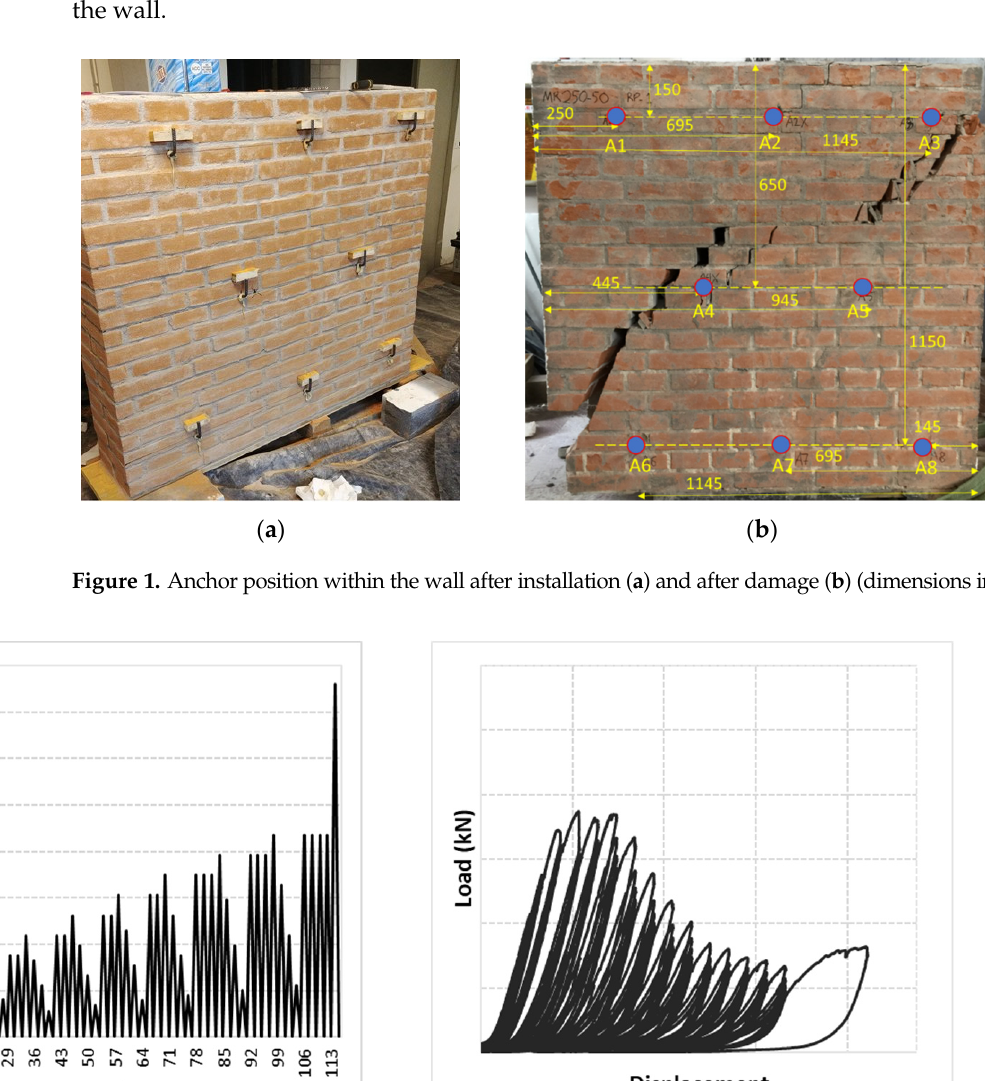
Figure 2. ( a ) Test protocol and ( b ) example of load-displacement curve of the actuator response of a wall ( b ). At the end of the wall tests the reinforced plaster was detached, and the masonry showed several major cracks along the diagonal. For the anchor tests, each anchor had a code (A1, A2 . . . A8) depending on the position within the wall (Figure 1). Figure 3. After the wall testing phase, most of the anchors were bent (Figure 4) which required additional measures to perform a tension test. In these cases, the anchors were